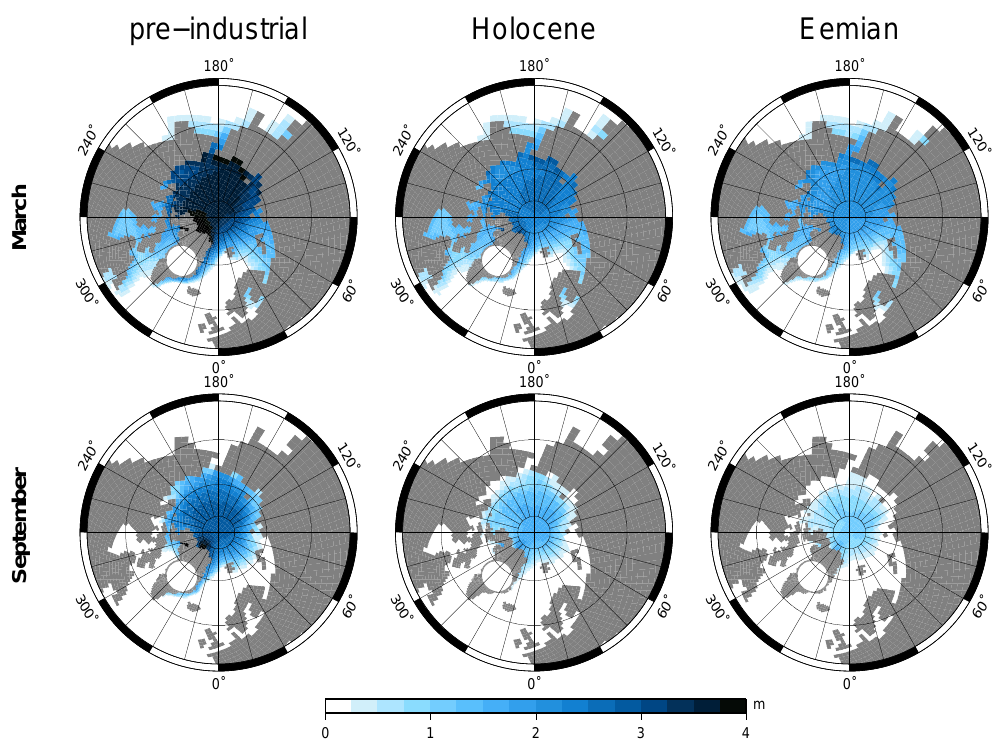
Fig. 5. Sea ice thickness in m in the Arctic Ocean in pre-industrial, Holocene, and Eemian conditions in March (upper row) and September (lower row).